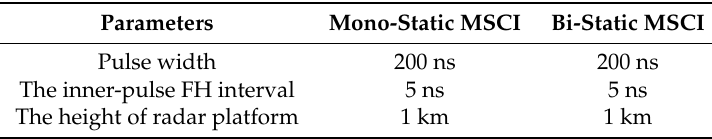
Table 4. Simulation parameters in this subsection.